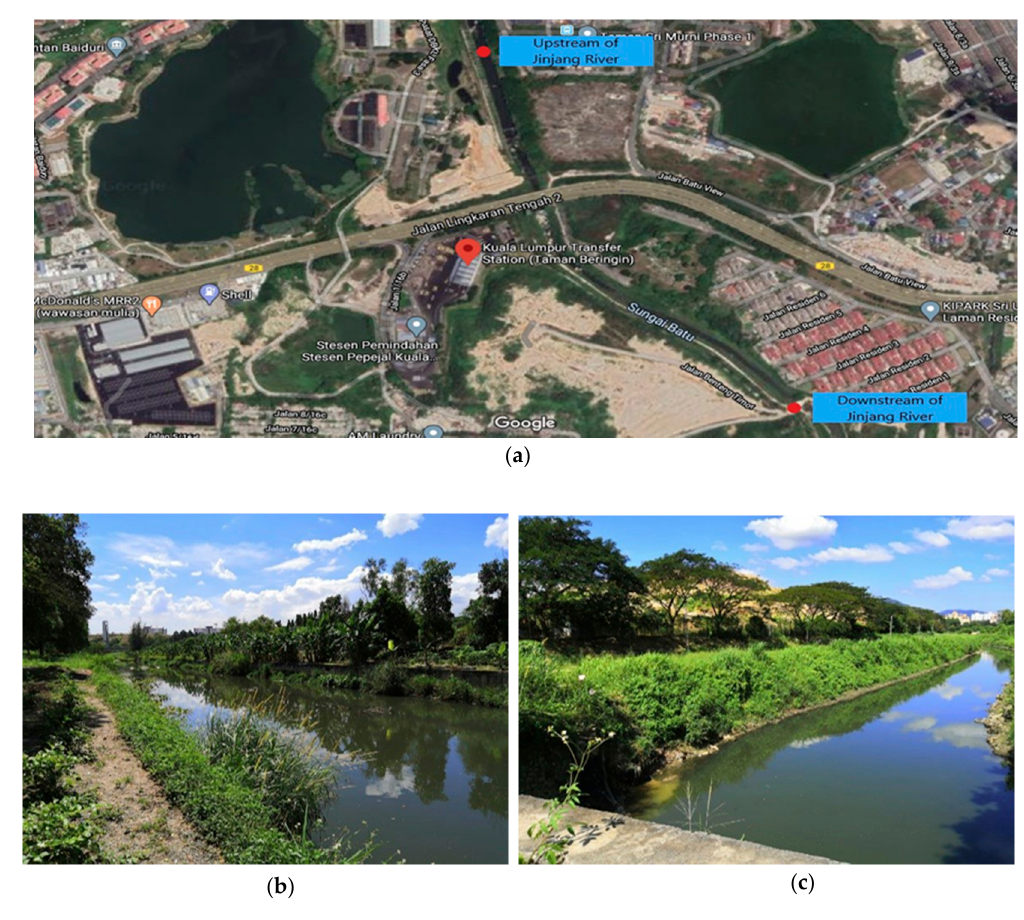
Figure 5. ( a ) Sampling points at Jinjang River, ( b ) upstream of Jinjang River, ( c ) downstream of Jinjang River.